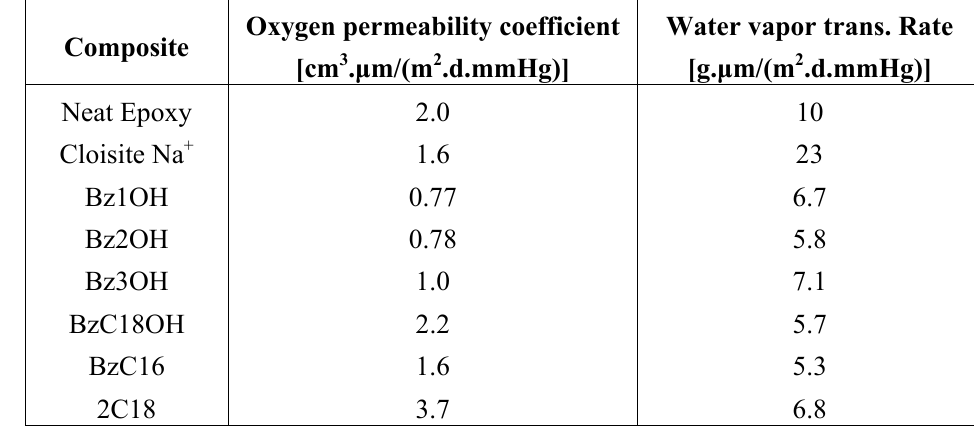
Table 4. Oxygen and water vapor permeation though the epoxy nanocomposites at 3 vol% filler fraction. Reproduced from reference [45] with permission from The American Chemical